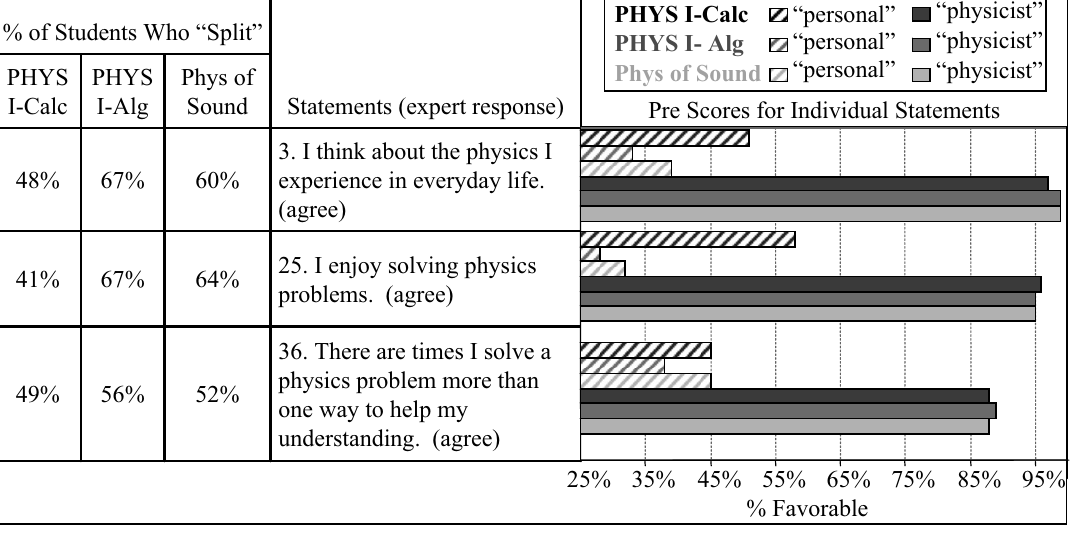
FIG. 4. Statements with the most splits—that is, where student’s “personal” and “physicist” responses do not match. Only pre data are shown. More than 50% of the students surveyed split on these three statements. The “personal” (cid:1) striped bars (cid:2) and “physicist” (cid:1) solid bars (cid:2) percentage favorable scores for these statements show large differences.